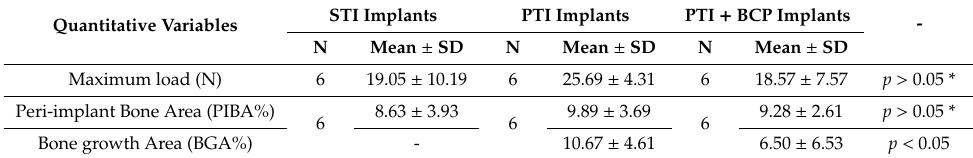
Table 1. Mean ± SD values of biomechanical and histomorphometrical quantitative variables in the three experimental groups.